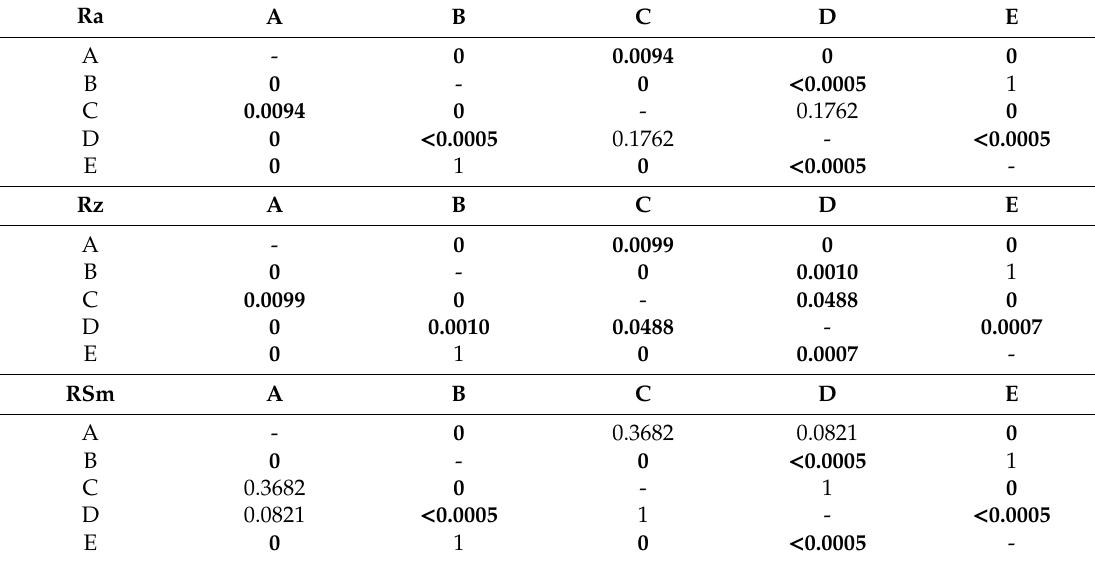
Table 8. Results of the Kruskal–Wallis test, p